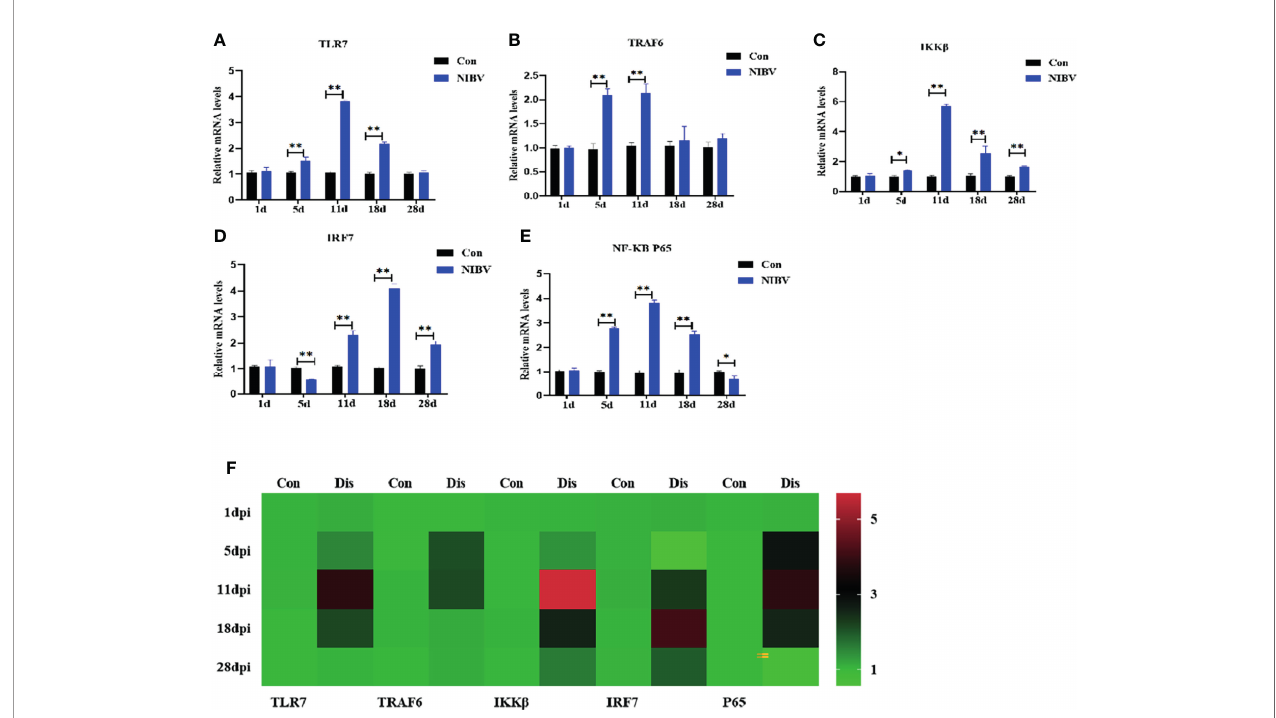
FIGURE 3 | Effects of NIBV on expression levels of TLR7/NF- k B signal axis related factors in chicken kidney tissue. (A – E) TLR7, TRAF6,IKK b ,IRF7 and NF- k B P65 mRNA expression levels; (F) Heatmap analysis of time and TLR7-related genes mRNA expression levels. *(0.01 < P < 0.05), **(P < 0.01), (N=6).